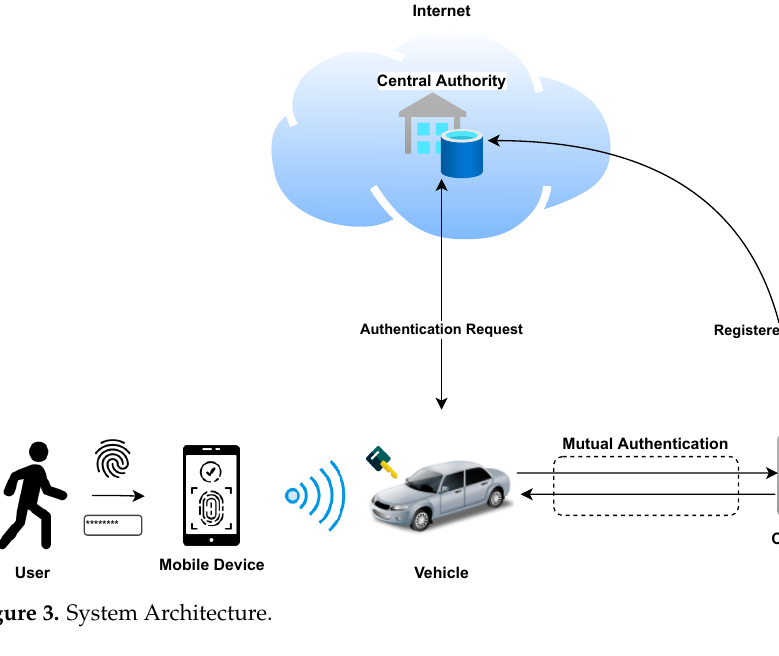
Figure 3. System Architecture.